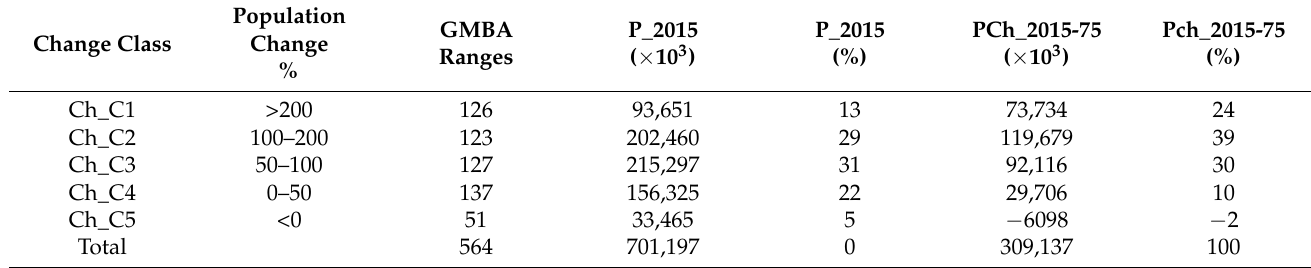
Table 4. GMBA ranges grouped in classes of percent population growth between 1975 and 2015 (Pch_2015-75).